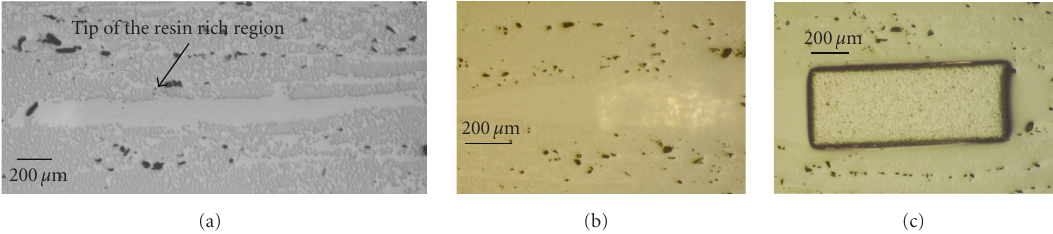
Figure 5: Tip of the resin pocket area in a 45-degree fiber orientation sample with integrated resistor at 3mm from the implant, cross-section (a); at 0.5mm from the implant, (b) and chip resistor cross-section (c) with magnification 50x.